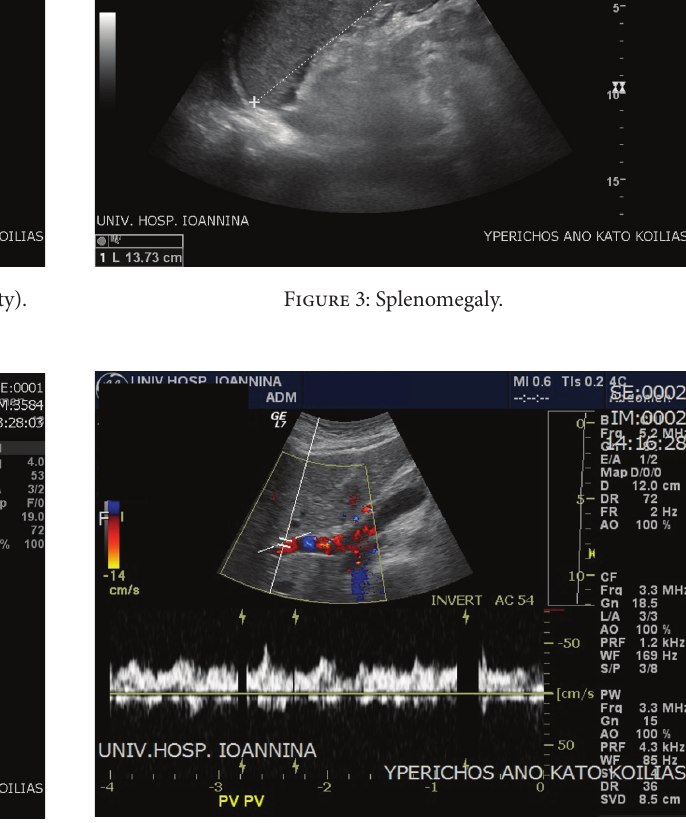
Figure 4: Reversed flow in the portal